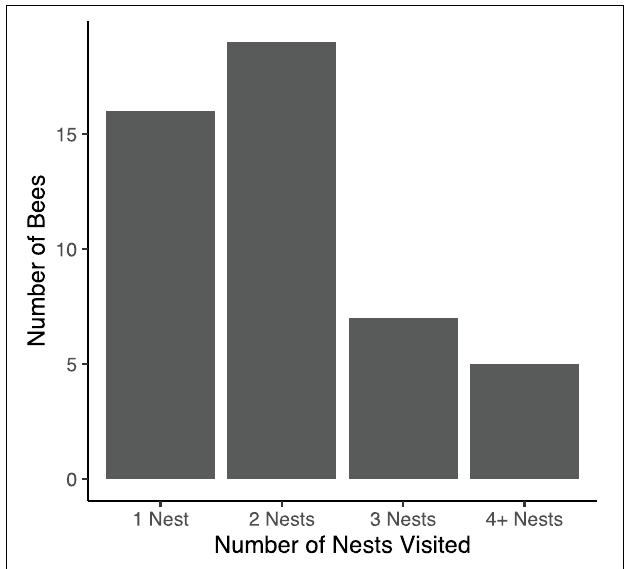
FIGURE 1 | Counts of uniquely identified bees observed at 1, 2, 3, or ≥ 4 nests over the course of the 2021 reproductive season.